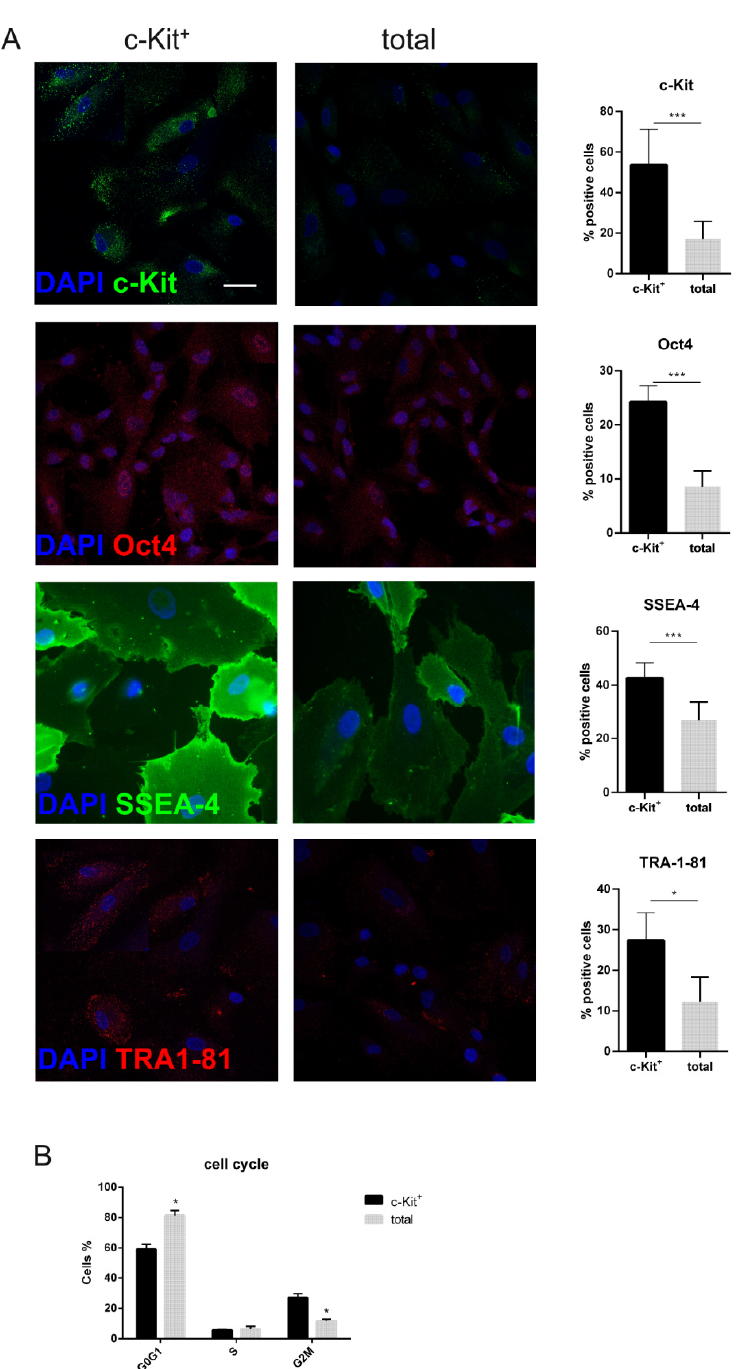
Figure 3. Total amniotic fluid cells and selected for c-Kit: comparison of cell cycle and stemness profile. ( A ) Representative immunofluorescence images and the relative graphs showing the expression of c-Kit, Oct4, SSEA-4, and TRA1-81 in total hAFSCs and c-Kit + cells. Images are superimposed between DAPI (blue) and c-Kit, Oct4 (both in green), SSEA-4 or TRA1-81 (both in red) signals. Scale bar= 10 µm. *** p < 0.001 = samples significantly different. ( B ) Quantitative cell cycle analysis by flow cytometry of total hAFSC and c-Kit + samples: * p < 0.05 = samples significantly different. At least 10,000 cells were evaluated for each cytofluorimetric analysis.